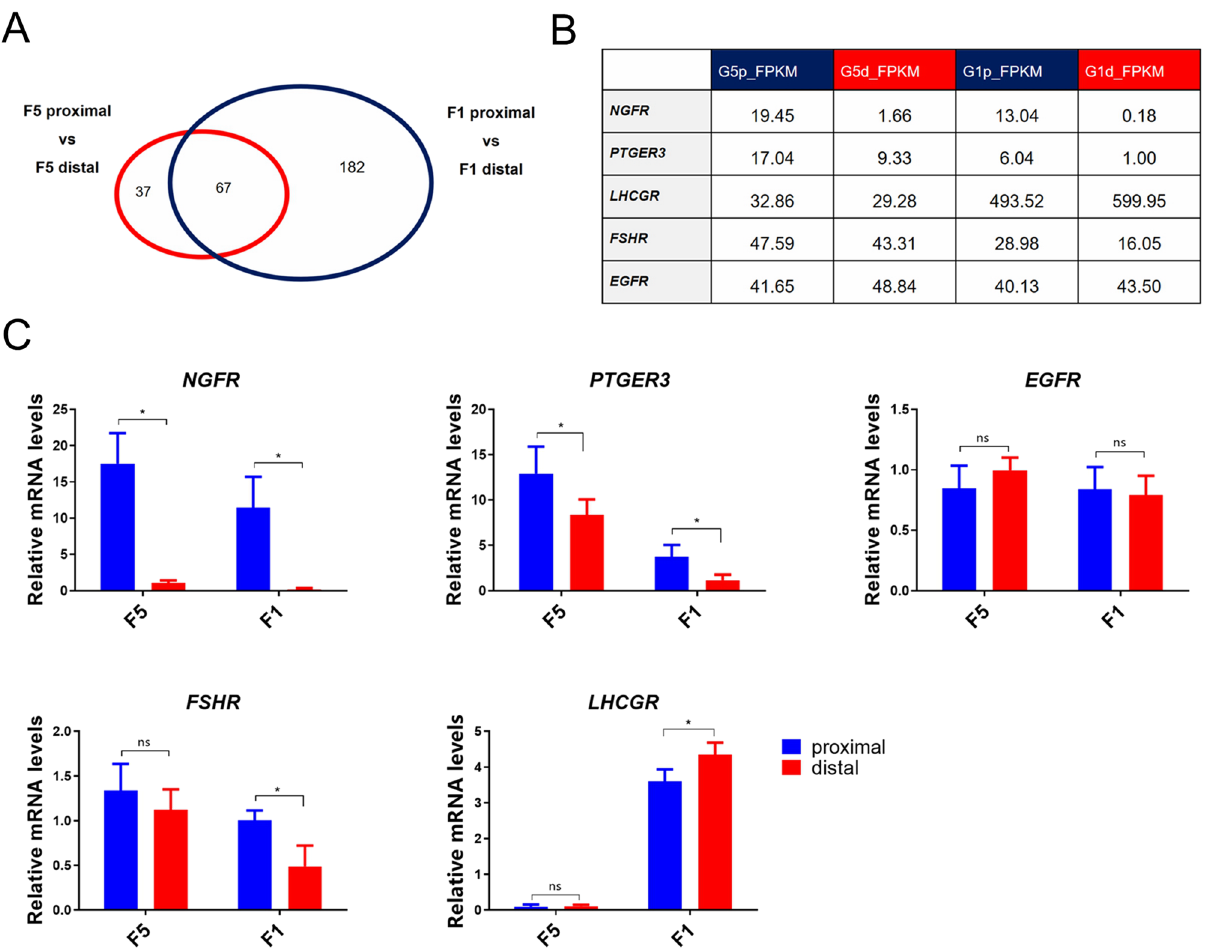
Figure 4. The comparison of the genes expression profiles of the Gp and Gd granulosa cells along the follicular growth. ( A ) The number of genes showed the similar expression tendency between the Gp granulosa cells and the Gd granulosa cells. ( B ) The FPKM value comparison of the genes (NGFR, PTGER3, LHCGR, FSHR and EGFR) along the follicular growth. ( C ) Quantitative real-time PCR validation of the genes expression (NGFR, PTGER3, LHCGR, FSHR and EGFR) along the follicular growth. The results were normalized based on the housekeeping gene GAPDH . Each data point represents mean of ten individuals (N = 10) * p <